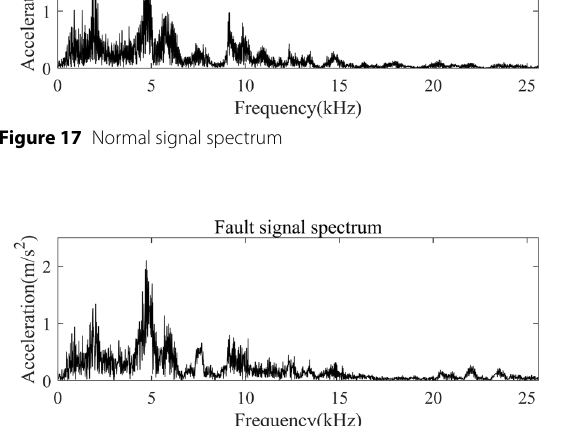
Figure 20 Mode number K of the optimized VMD